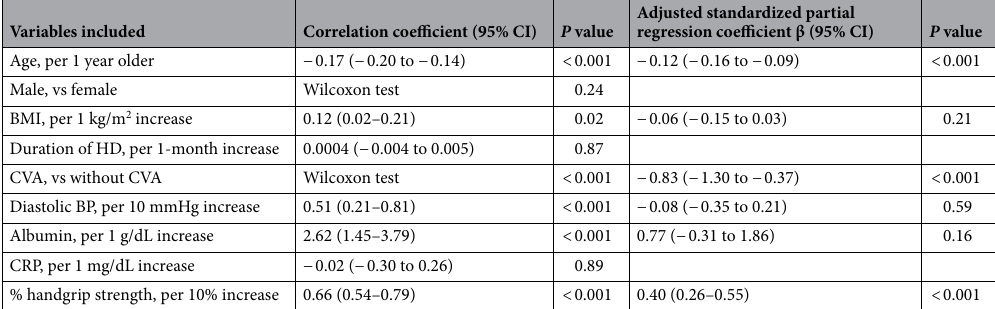
Table 2. Correlation coefficients and multivariate analyses of variables related to the MoCA-J score. Adjusted for all listed variables. MoCA-J Japanese version of the Montreal Cognitive Assessment, CI confidence interval, BMI body mass index, CVA cerebrovascular disease, CRP C-reactive protein, BP blood pressure.